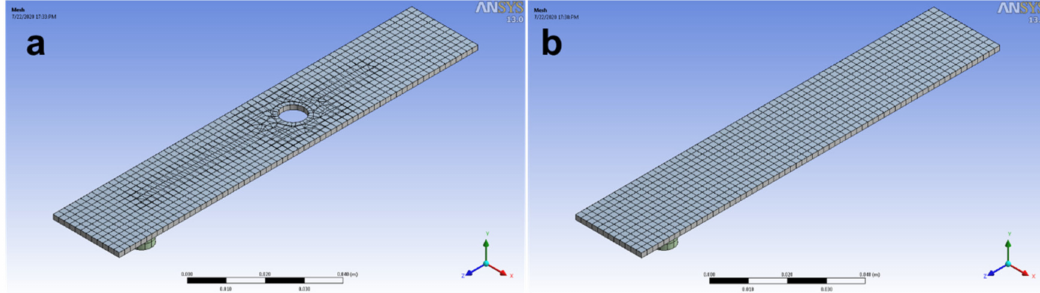
Figure 4. Examples of mesh models used for finite element method (FEM) analysis: ( a ) Group 3 sample (W = 24, D = 8); ( b ) Group 2 sample (W = 24).